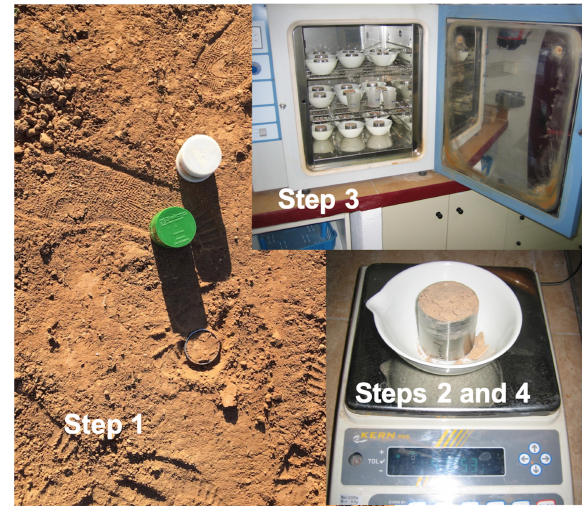
Figure 4. Gravimetry method used for producing a reference data set. Step 1: taking the soil sample. Steps 2 and 4: weighing the sam- ple. Step 3: drying the